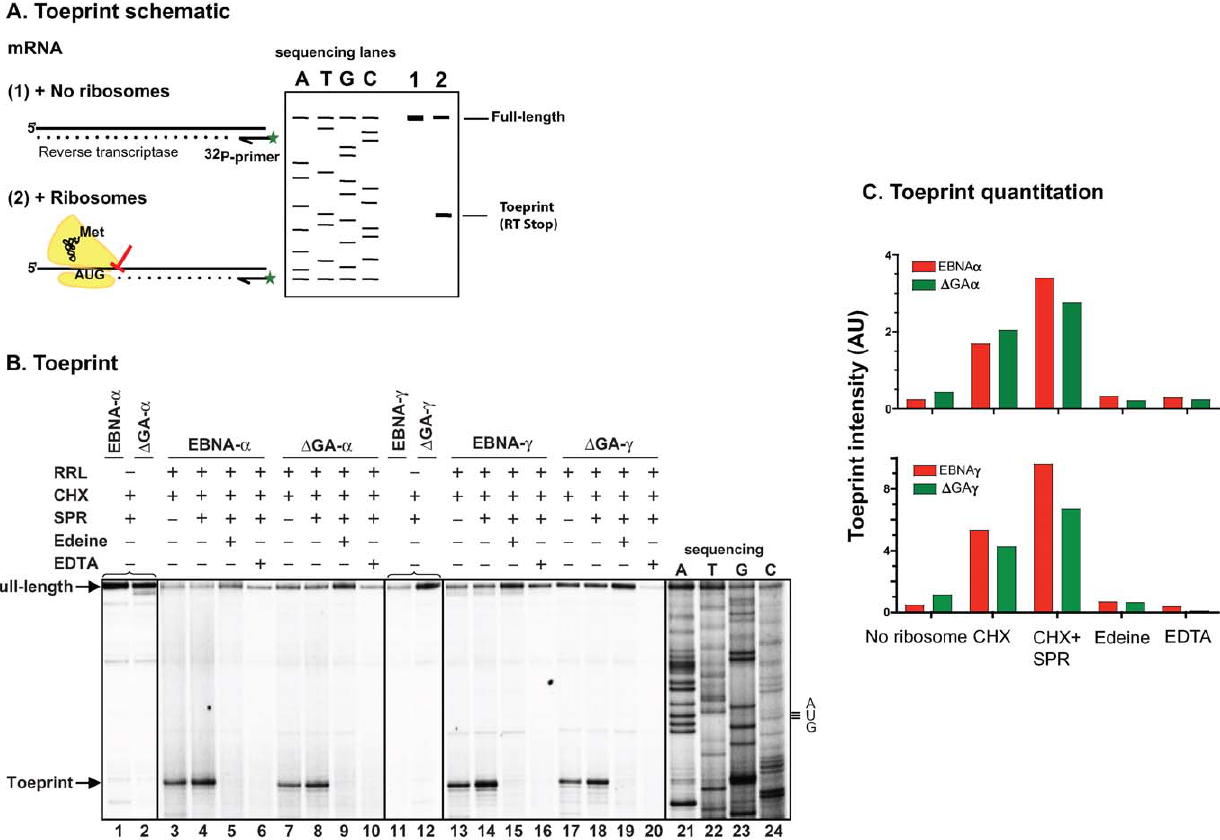
Figure 2. GAr inhibits overall translation of EBNA1 mRNA without affecting ribosomal initiation. ( A ) Schematic of the primer extension inhibition (toeprint) assay illustrating how presence of ribosomes bound to the mRNA initiation codon is detected by analysis of reverse transcriptase (RT) products of varying length. ( B ) The mRNA encoding EBNA1 ( a or c ) and EBNA1 D GA ( a or c ) were used as template for the toe-printing assay. Reactions were carried out with either no ribosomes, or in presence of elongation inhibitors, cycloheximide (CHX), CHX plus sparsomycin (SPR), initiation inhibitor, edeine or magnesium chelator, EDTA. Dried gels were analyzed using a PhosphoImager. The full-length and shorter RT (toeprint) products are indicated by arrows. The toeprint corresponds to 17 nucleotides downstream of the AUG codon as judged by the size of fragments on the sequencing gel shown on the right. ( C ) The intensity of the 32 P radiolabeled toeprint bands observed under the indicated conditions was quantitated and is shown as arbitrary units (AU.) Data are representative of 3 different experiments.